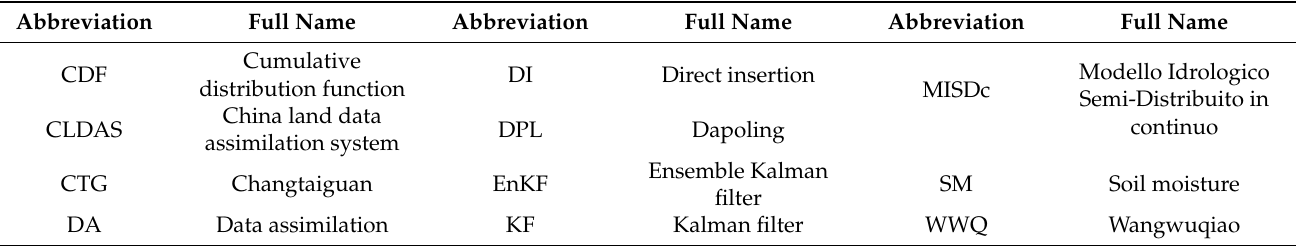
Table A2. Full name of the abbreviated nouns used in the